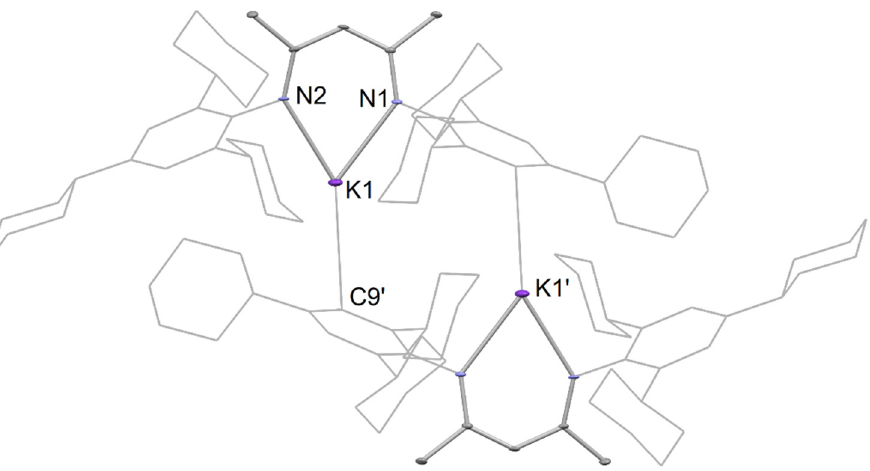
Figure 3. Partial thermal ellipsoid plot (25% probability surface for displayed ellipsoids) of the molecular structure of 6 (hydrogen atoms omitted; TCHP groups shown as wireframe for clarity). Selected bond lengths (Å) and angles ( ◦ ): K(1)-N(1) 2.633(3), K(1)-N(2) 2.619(3), K(1)-C(9)’ 3.309(3), N(1)-K(1)-N(2) 68.23(10) .